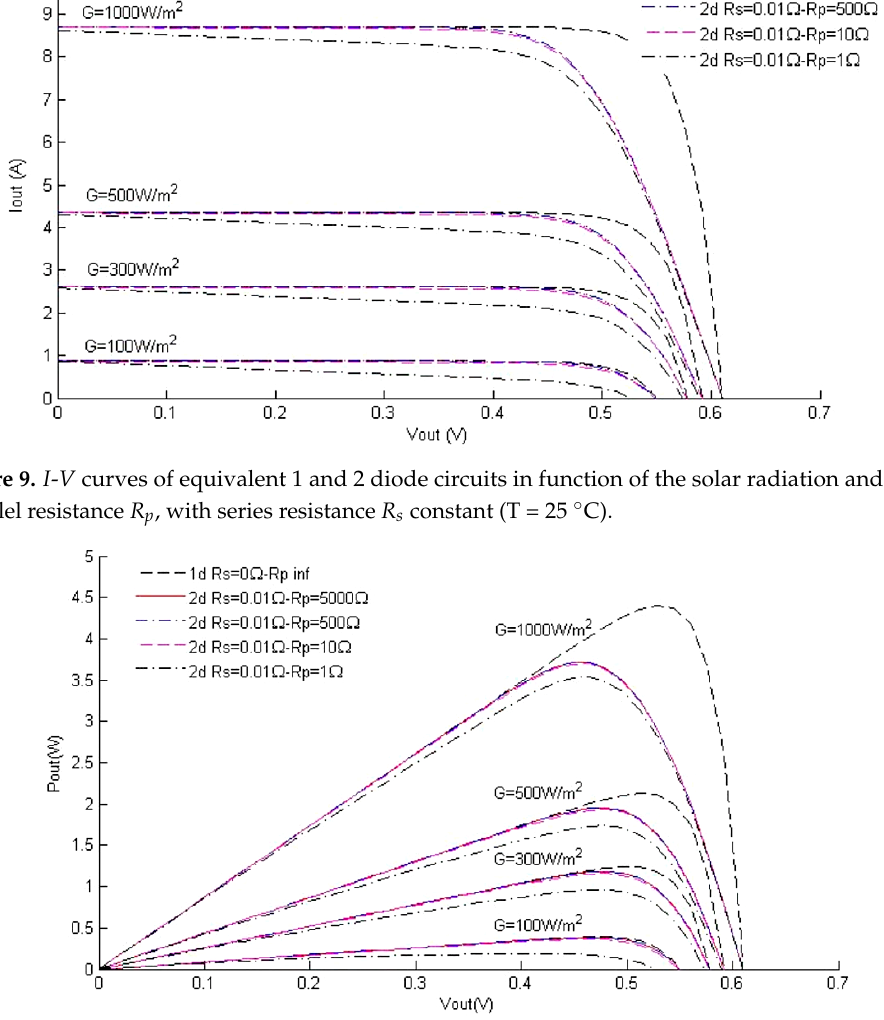
Figure 10. P - V curves of equivalent 1 and 2 diode circuits in function of the solar radiation and of the parallel resistance R p , with series resistance R s constant (T = 25 °C).